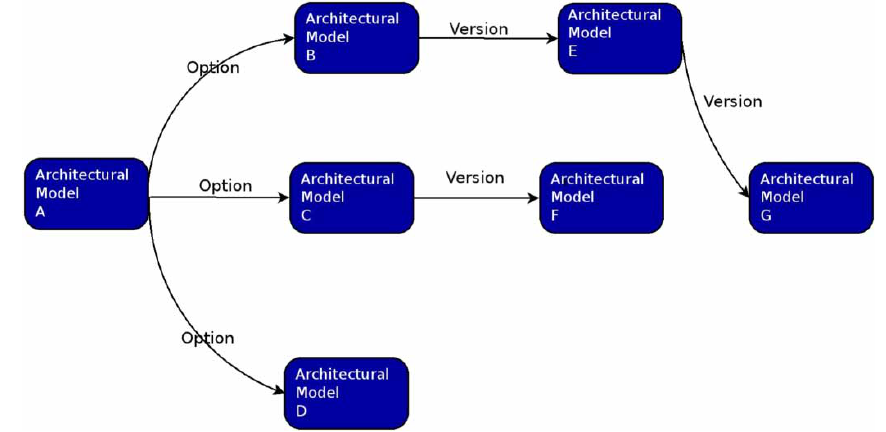
Fig. 2. Optioning and versioning relationship